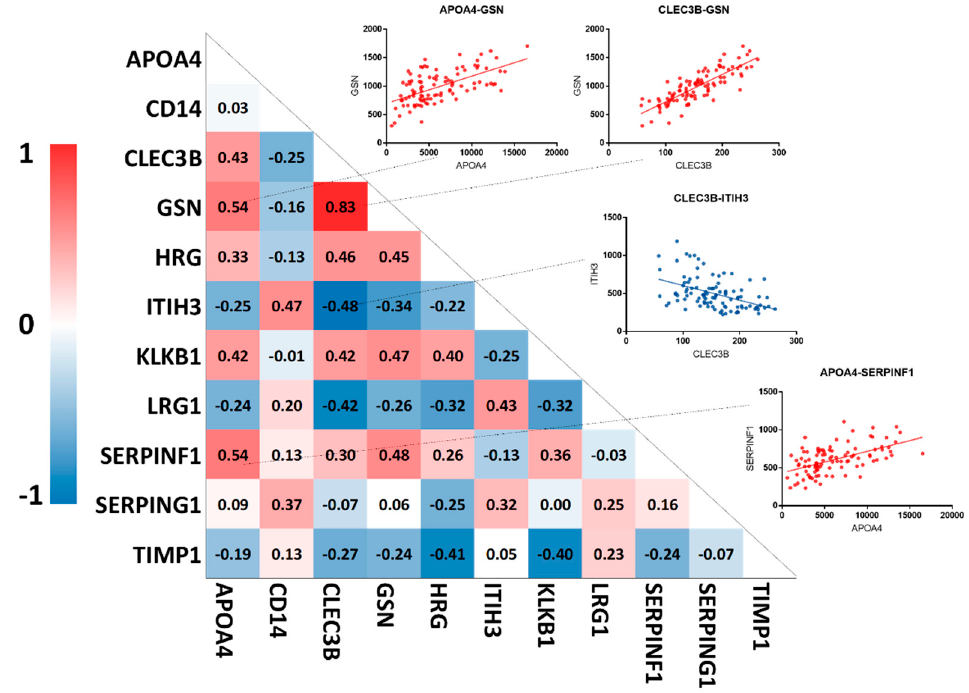
Figure 5. Plasma concentration correlations between the 11 protein candidates. Red indicates a positive correlation and blue indicates a negative correlation.